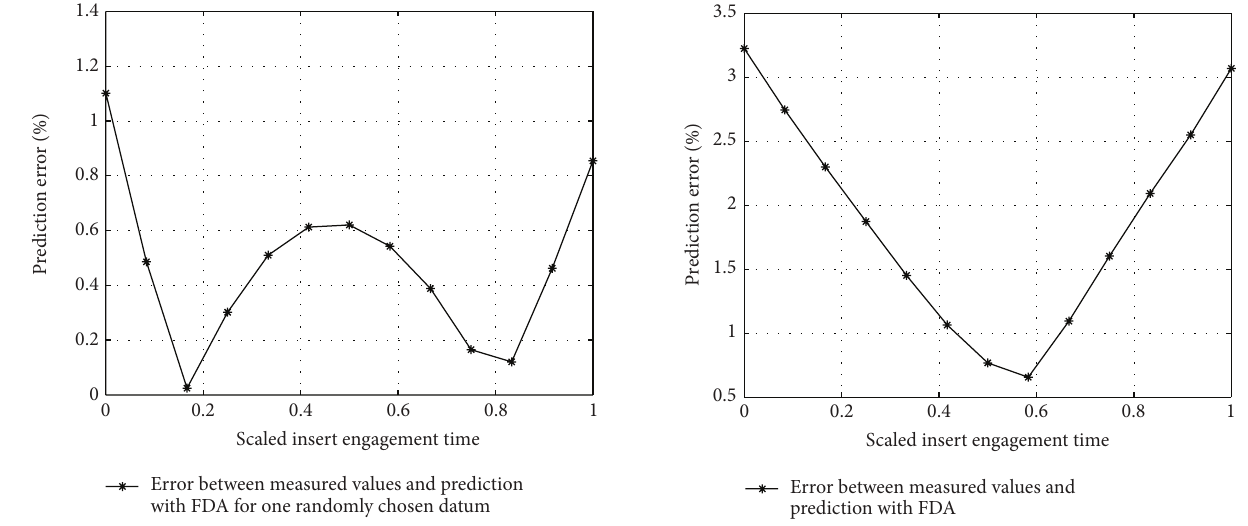
Figure 9: Average prediction errors of the proposed model when all testing FD are